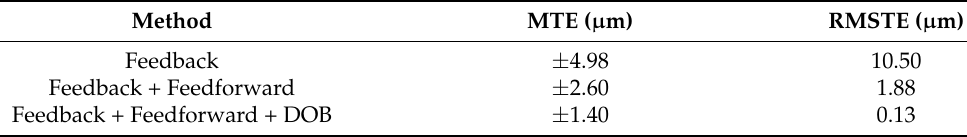
Figure 18. Trajectory tracking performance ( a ) Trajectory tracking results. ( b ) Partial enlargement. ( c ) Tracking errors. Table 4. Tracking performance of the mechanism with different control